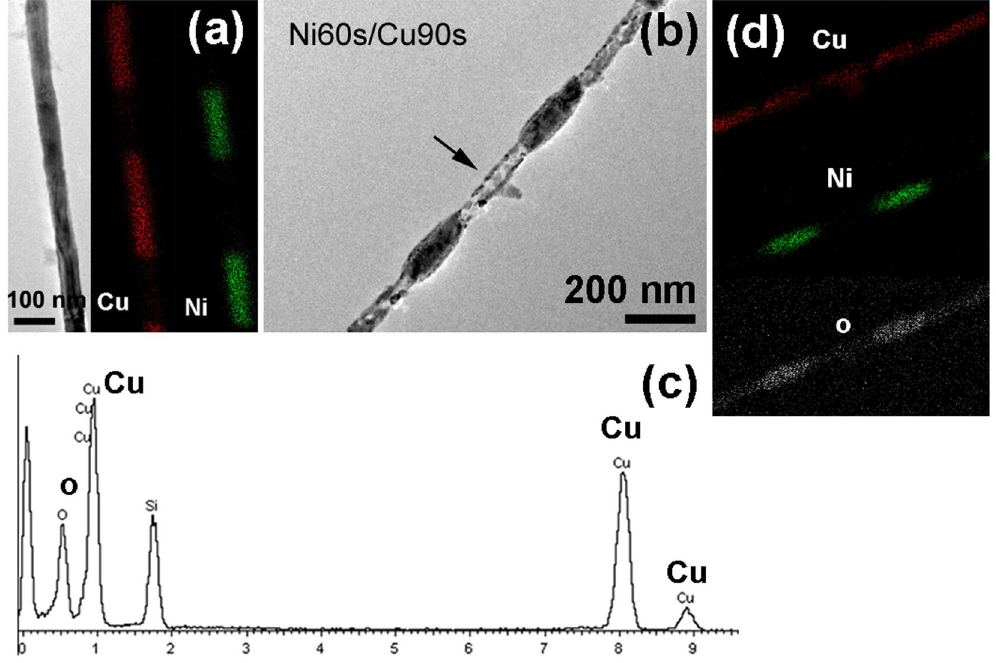
Figure 3. Characterization results of Ni60s/Cu90s sample. ( a ) The TEM and element EDS mapping image of the single nanowire; ( b ) the same nanowire after annealing at 700 °C for 2 h in air. ( c ) EDS result of the tubular structure that has been labelled by arrow in ( b ); ( d ) EDS mapping image of the nanostructure in ( b